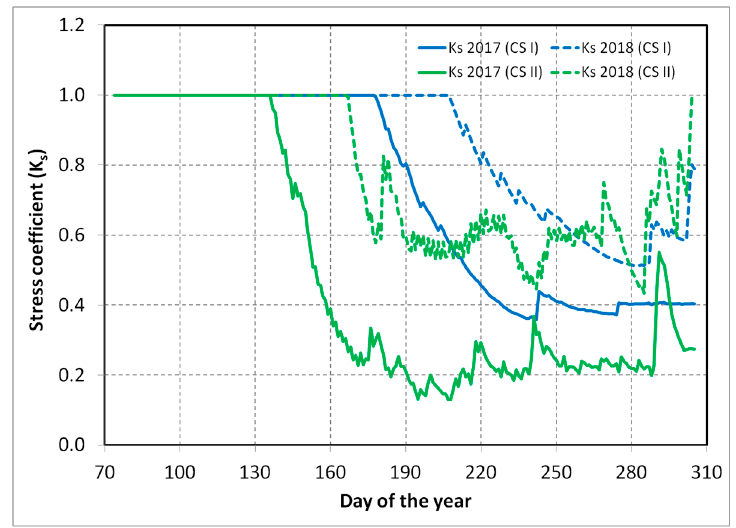
Figure 6. Seasonal evolution of stress coefficients, estimated by the SIMDualKc model, at case study I and II, during the vegetative cycles of 2017 and 2018.